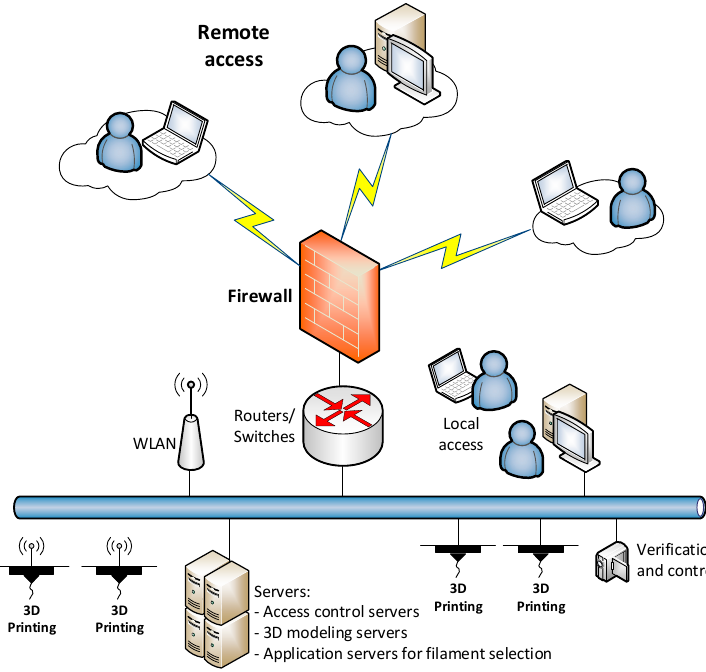
Figure 5. Architecture of a remote rapid prototyping laboratory.